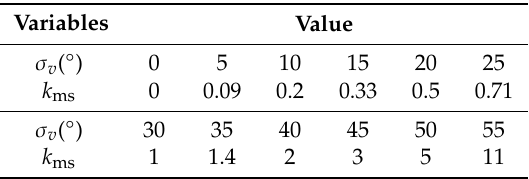
Table 3. Duty ratio scale switching table.